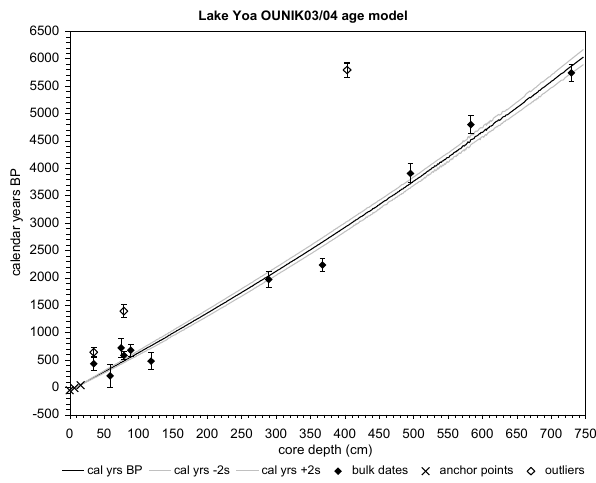
Fig. 2. Calendar age-depth model for the composite OUNIK03/04 core from Lake Yoa (from Kr¨opelin et al.,